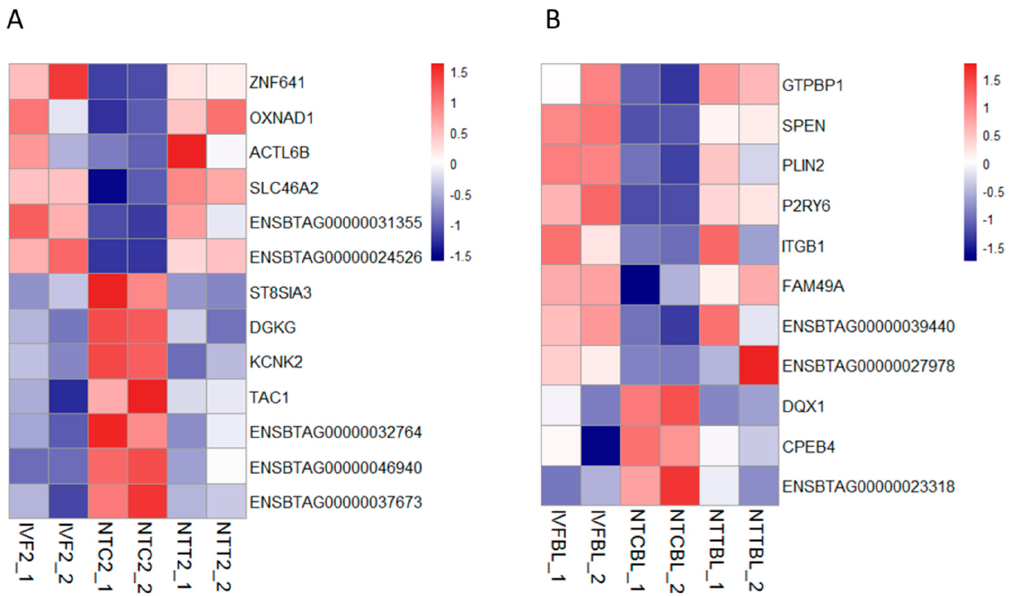
Figure 3. Restored gene expression in cloned embryos by Vc treatment. Heatmap illustration showing the genes that were restored by Vc treatment in cloned embryos compared to their in vitro fertilization (IVF) counterparts. Di ff erentially expressed genes (DEGs) were analyzed under the conditions of p < 0.01, FC > 2, and FPKM > 1 in at least one group. ( A ) Restored gene expression in the two-cell